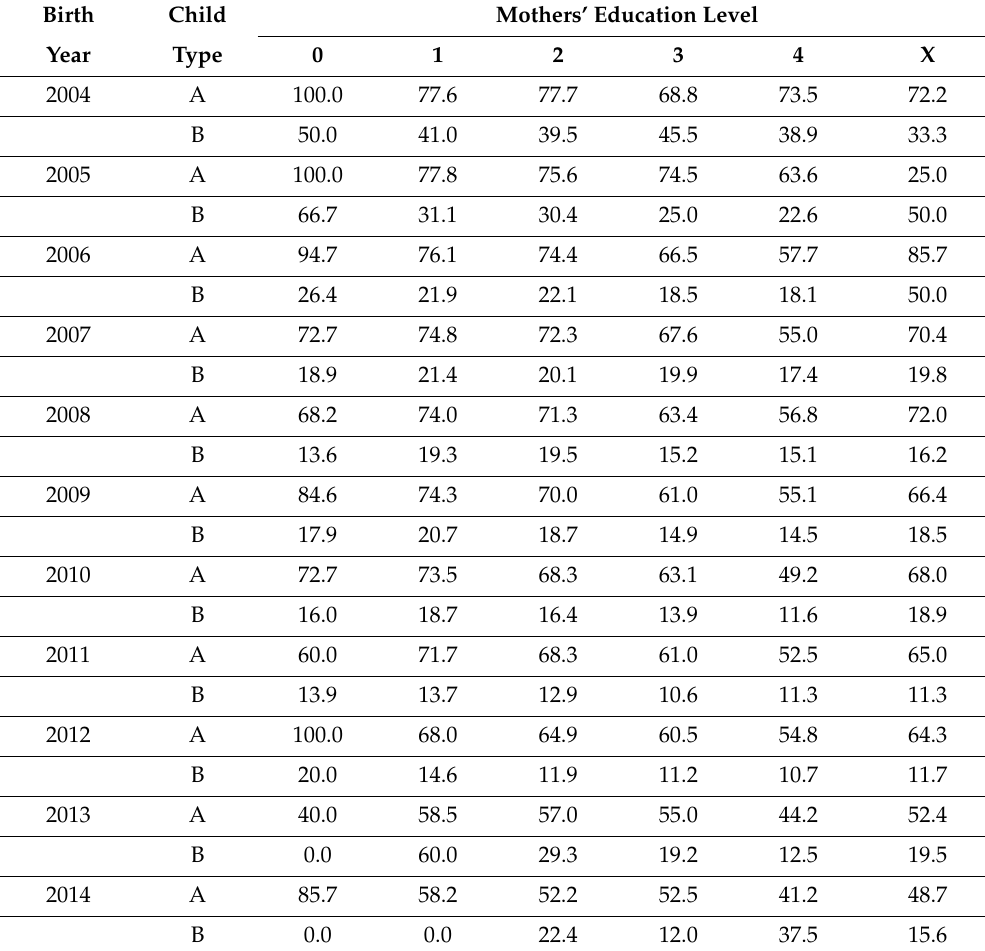
Table 3. Return rates by mothers’ education level per birth cohort in 2016. Birth Child